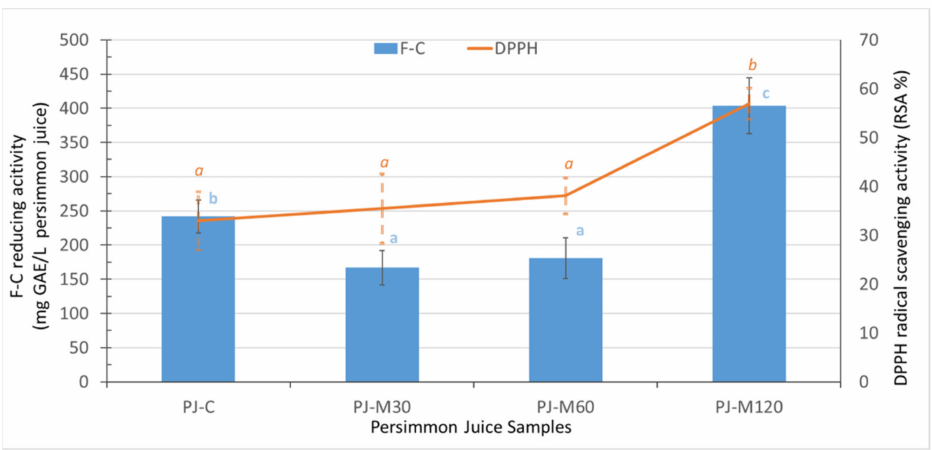
Figure 4. Antioxidant potential of persimmon juice without (PJ-C) and after persimmon pulp treatment at different microwave heating conditions (PJ-M30, PJ-M60, and PJ-M120 using the Folin– Ciocalteu (F–C) and DPPH • assays. Error bars represent the standard deviation (sd) of the mean value ( n = 4). Different lowercase letters in the same test indicate significant differences ( p <